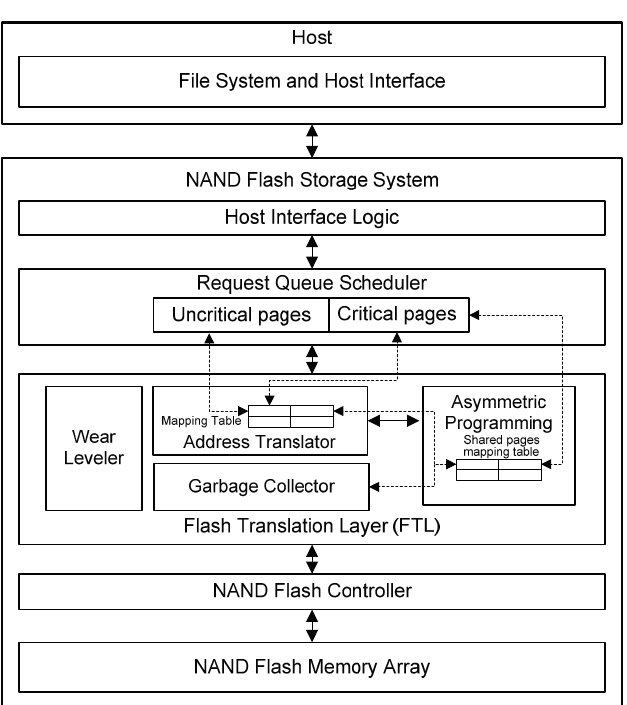
Figure 4. System architecture of Asymmetric